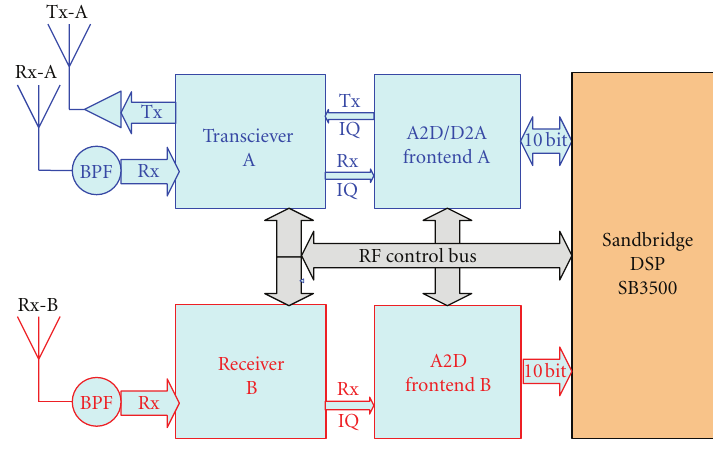
Figure 16: SDR platform using three antennas.